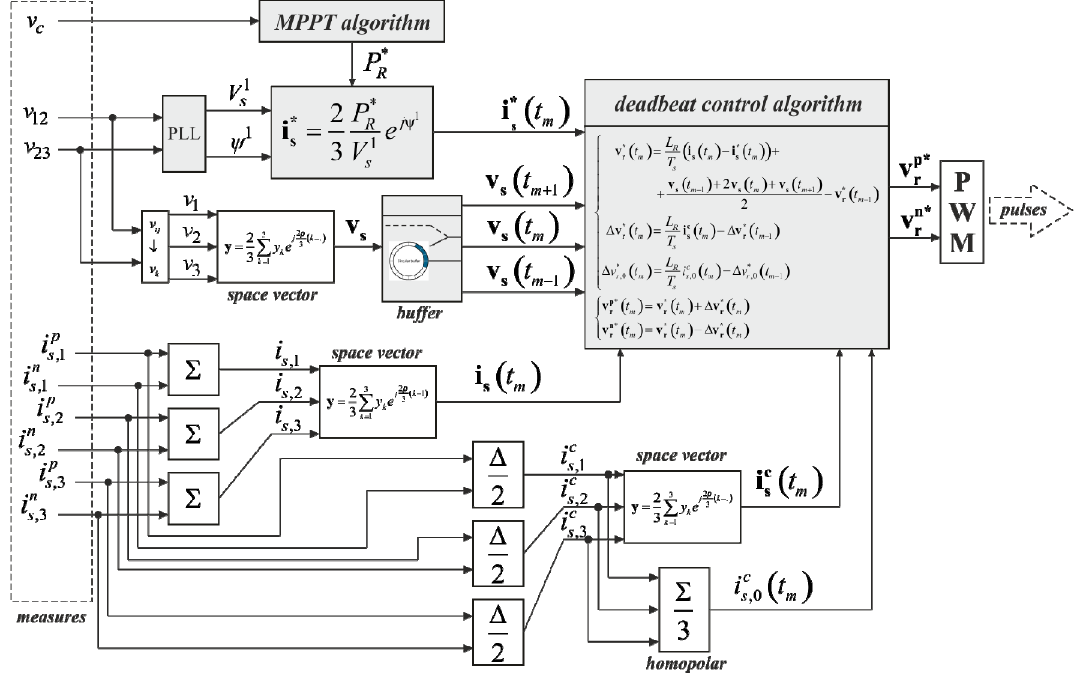
Figure 4. Control diagram of a grid connected PV generation system via an interleaved inverter.